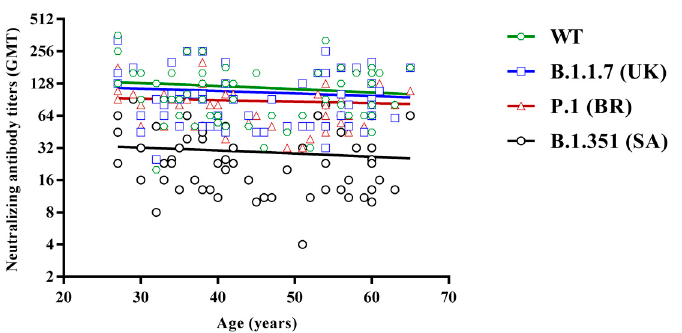
Figure 3. Regression analysis of neutralizing antibody titers against the wild-type (green, R2 = − 0.12), B.1.1.7 (blue, R2 = − 0.09), P.1 (red, R2 = − 0.07) and B.1.351 lineages (black, R2 = − 0.11), according to subjects’ age.